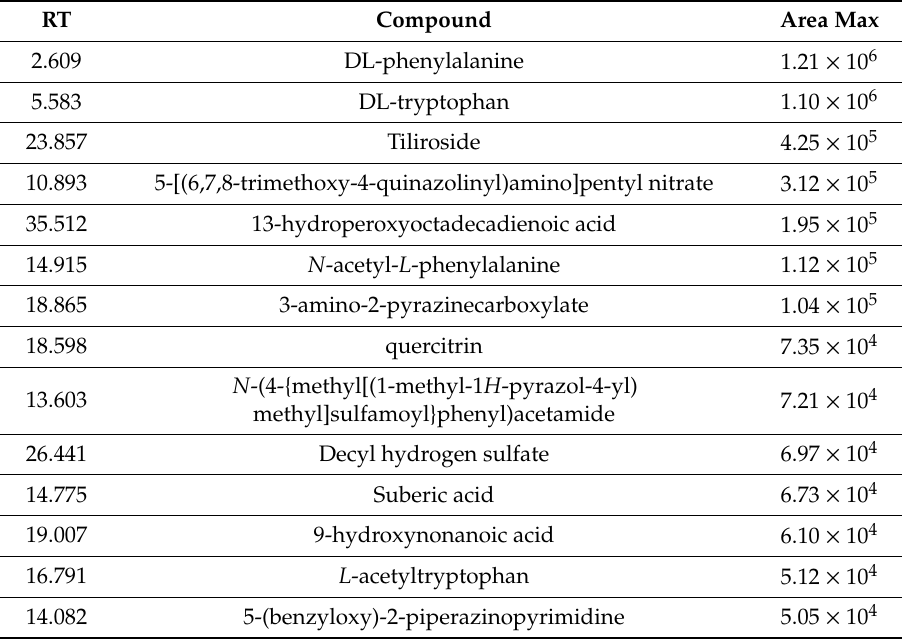
Table 2. Table showing the composition of the M. pseudolavatera Webb & Berthel. methanolic leaf extract as elucidated by liquid chromatography coupled with mass spectrometry (LC-MS). RT